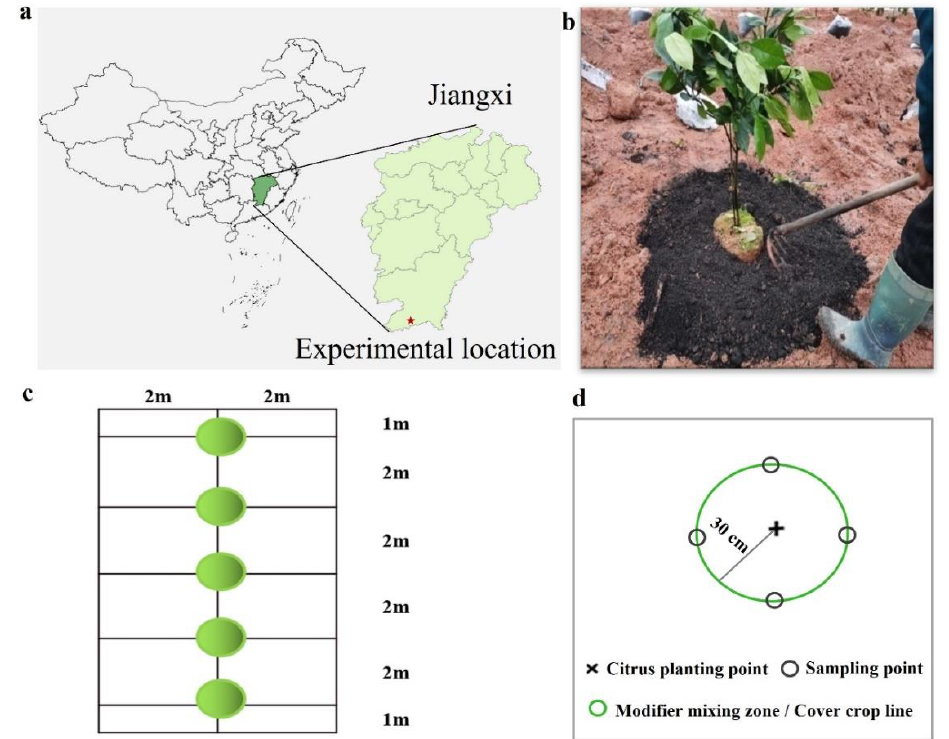
Figure 1. Experimental site and sampling details. ( a ) Location of the experimental site; ( b ) process of changing the soil to grow navel oranges; ( c ) distribution scheme of each treatment in the test area; and ( d ) distribution of the holes and sampling points.